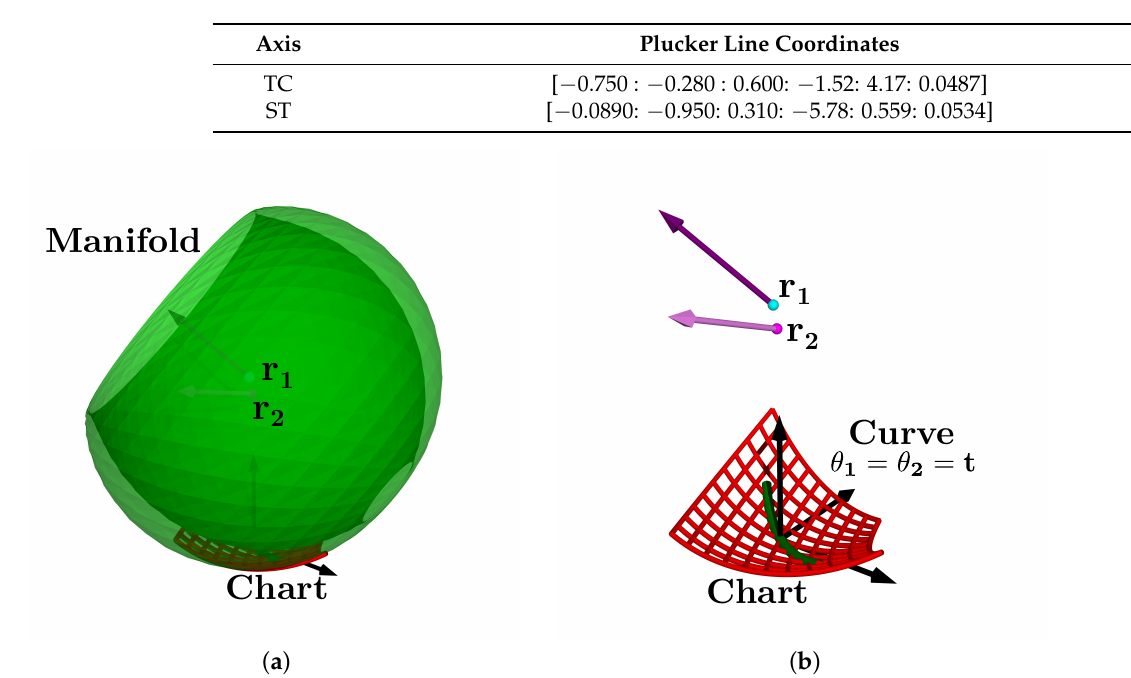
Table 9. Plucker line coordinates.